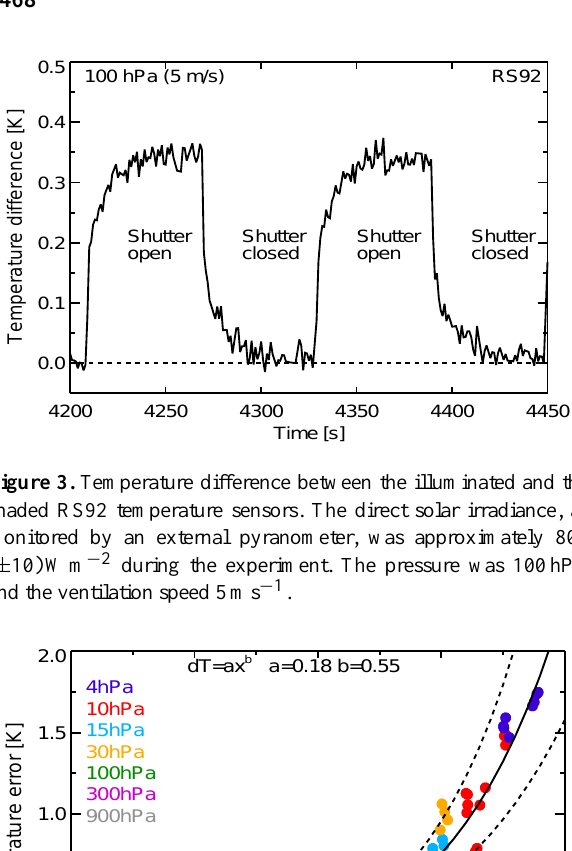
Figure 4. Results of radiation experiments performed at various Fig. 4. Results of radiation experiments performed at various ventilation speeds, v , and pressures p . Ventilation ventilation speeds, v , and pressures p . Ventilation speeds are 2.5 speeds are 2.5 and 5 ms − 1 . The solar irradiance I was monitored externally, and was additionally varied by the and 5ms − 1 . The solar irradiance I was monitored externally and use of grey filters. The solid black line indicates the best fit to the data, whereas the dashed lines indicate the was additionally varied by the use of grey filters. The solid black estimated uncertainty range of the fit. line indicates the best fit to the data, whereas the dashed lines indi- cate the estimated uncertainty range of the